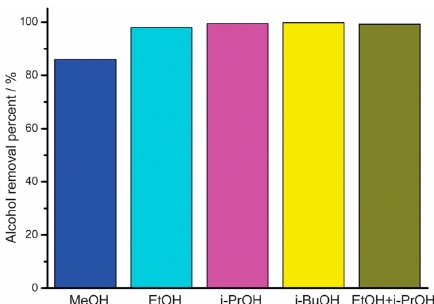
Figure 6. Adsorptive separation performance from of the superhydrophobic ZIF-90 for the removal of alcohols from alcohol/water mixtures; Reproduced with permission from [75].